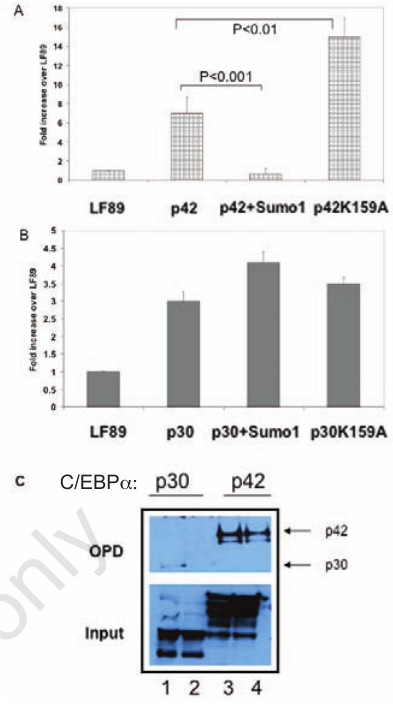
Figure 2. Transient transfection analysis of Lactoferrin promoter (LF89) harboring a C/EBP site in HEK293T cells with expres- sion plasmids for the two C/EBP a isoforms and SUMO-1. A. Transient transfection analysis using a lactoferrin promoter plas- mid (LF89) harboring a C/EBP site. HEK293T cells were transiently cotrans- fected with LF89 and expression plasmids for p42 C/EBP a (wild-type) or p42 K159A (mutant) with and without SUMO-1. Normalized luciferase (to that of b -galac- tosidase, see Materials and Methods) values have been represented as a fold change over the enzyme activity of LF89 promoter plas- mid alone (equal to 1) The figure repre- sents normalized mean+/- s.e. obtained from 3independent experiments, each per- formed in triplicate. B. Transient transfec- tion analysis of LF89 with expression plas- mids for p30C/EBP a (wild-type or p30 K159A mutant) with and without SUMO-